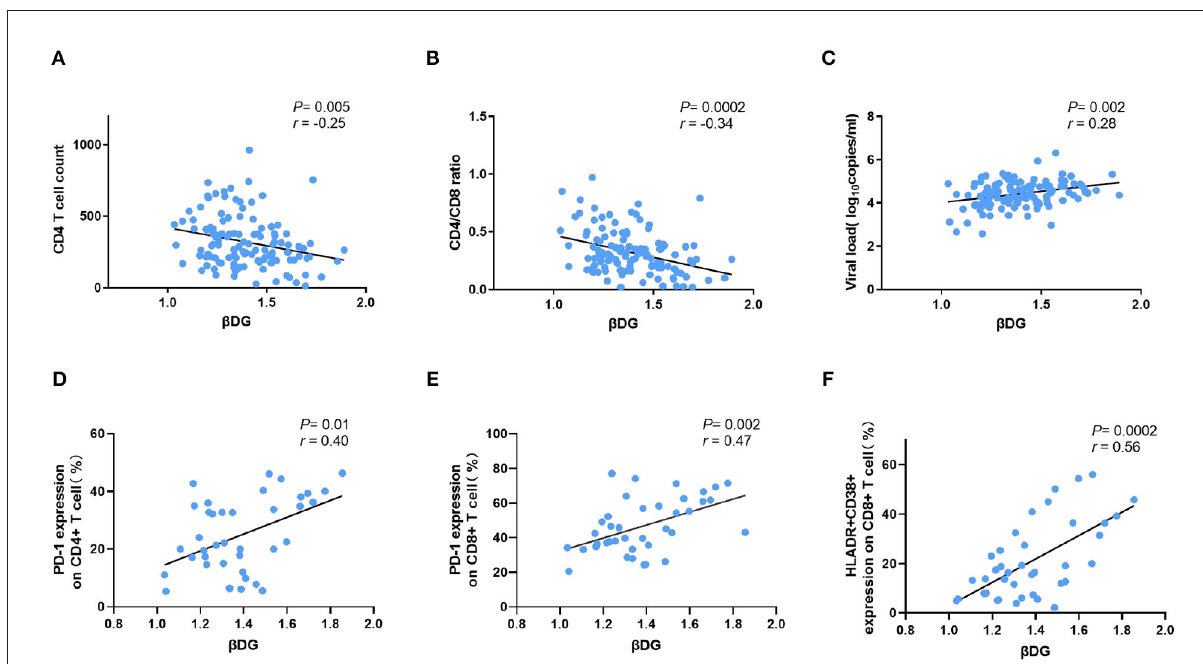
FIGURE1 Comparison of β DG with markers of CD4T cells, viral load, and immune activation markers. (A) β -D-glucan ( β DG) levels were correlated with CD4T cell count ( n = 119). (B) β DG levels were correlated with CD4/CD8 ratio in untreated patients ( n = 118). (C) β DG levels were correlated with plasma viral load at baseline ( n = 120). (D) There were positively correlations among BDG levels and the expression of PD-1 on CD4 + T cell ( n = 39), (E) the expression of PD-1 on CD8 + T cell ( n = 39), (F) the co-expression of HLADR and CD38 on CD8 + T cell ( n = 39). All the analysis using by nonparametric spearman